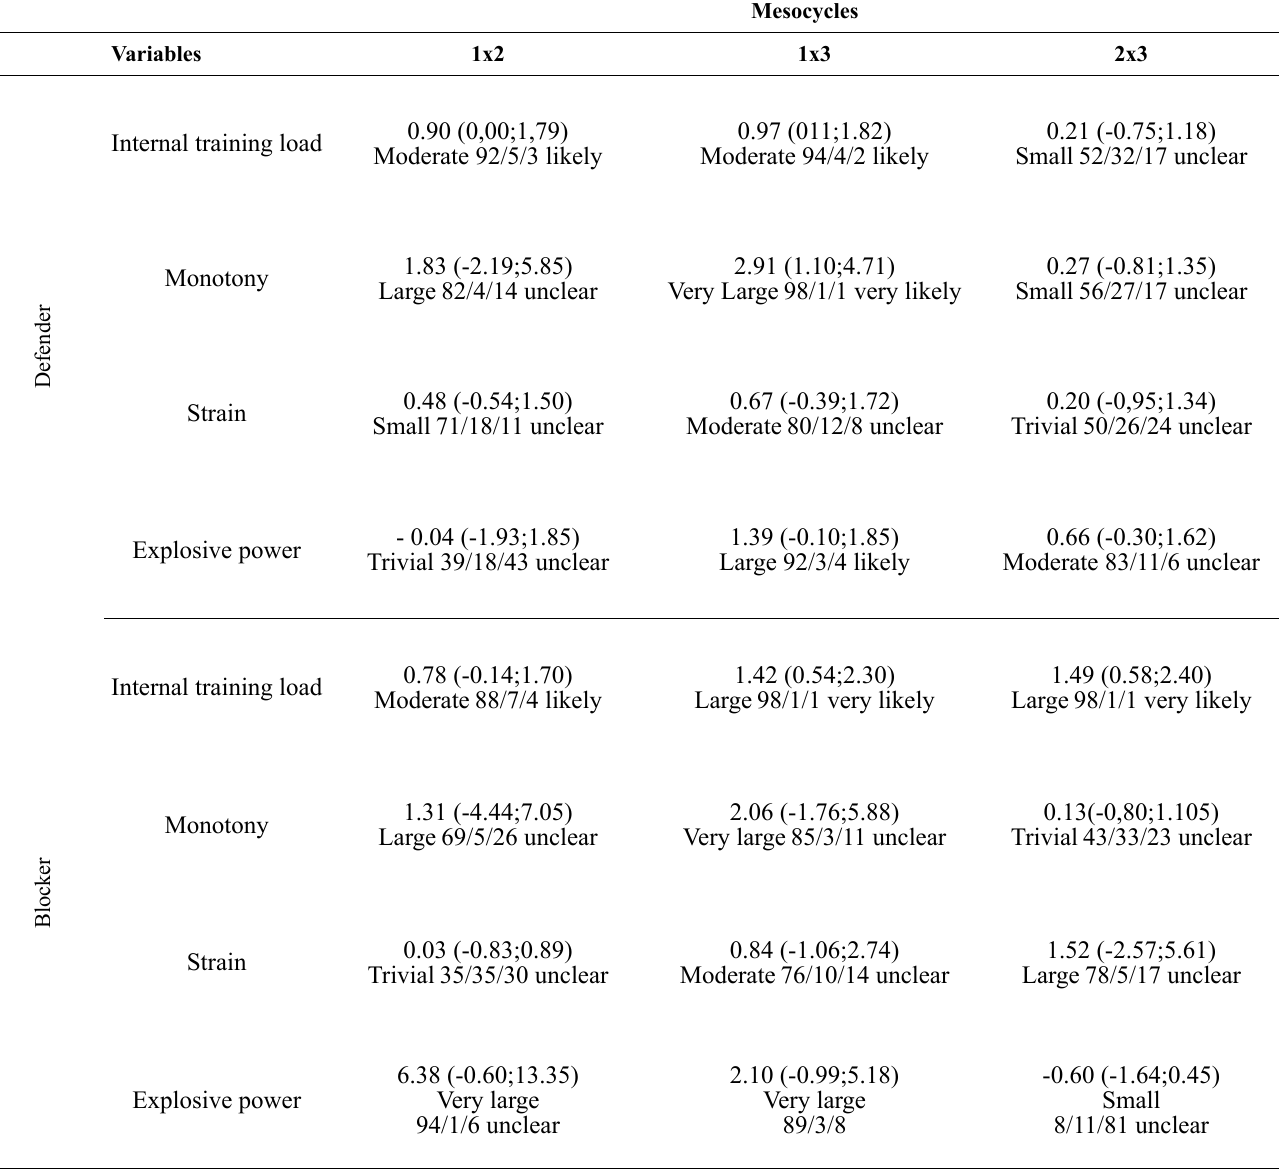
Table II. Standardized mean difference (SMD), 90% CI (confidence interval), magnitude of effect size and probabilities of comparison among 1 st , 2 nd and 3 rd mesocycles for each player’s position training